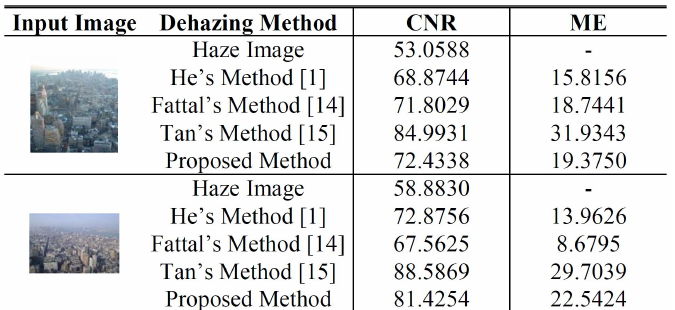
Table 2. Quantitative performance of the proposed and three state-of-the-art dehazing methods in the sense of both contrast-to-noise ratio (CNR) and the measure of enhancement (ME).